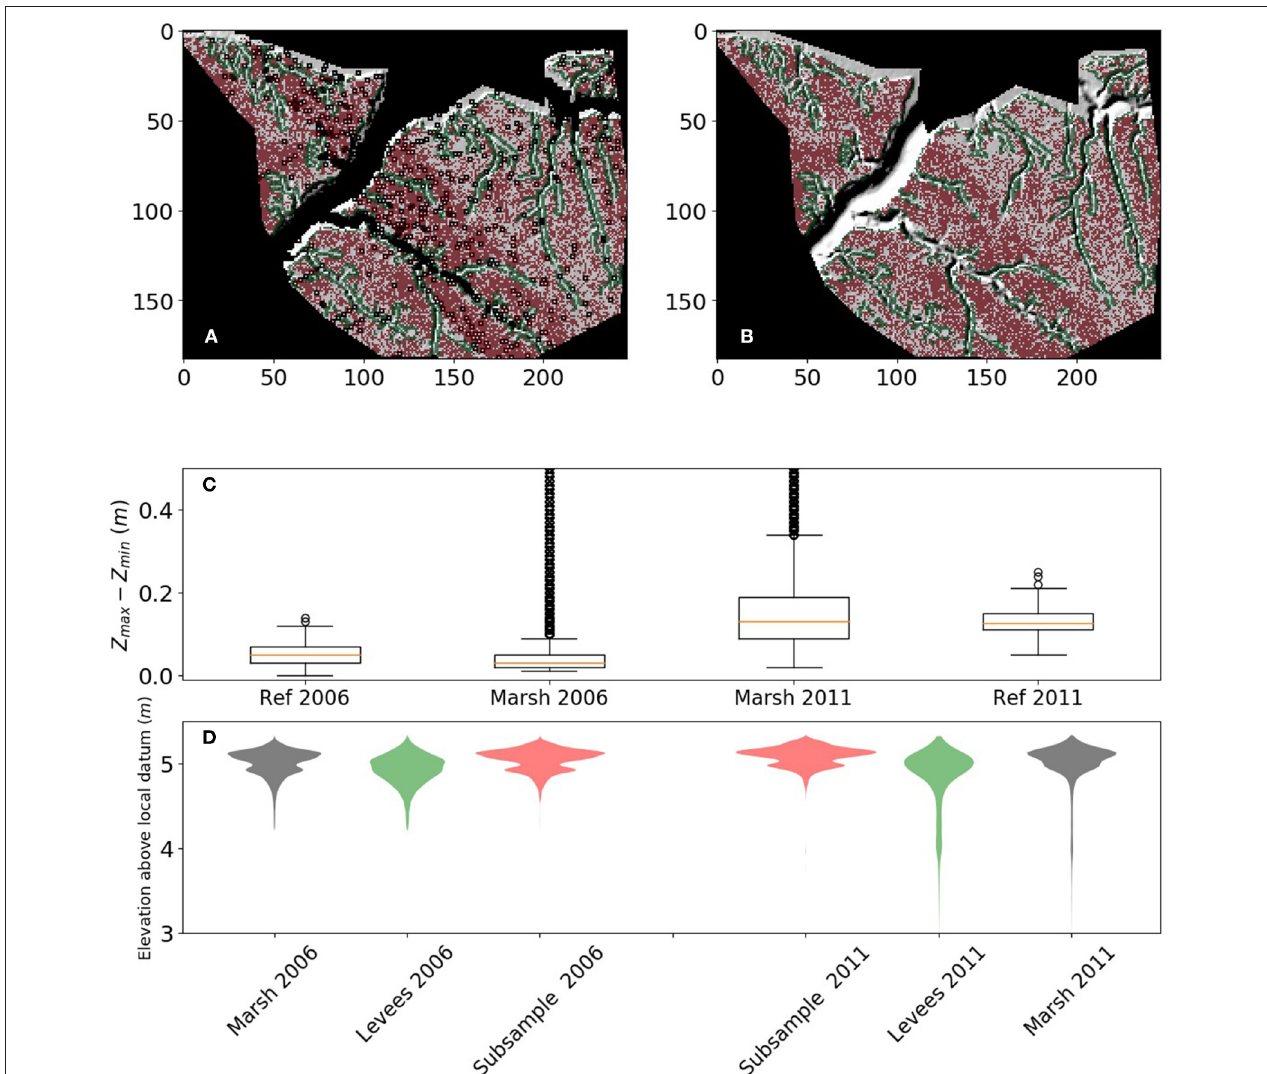
FIGURE 3 | Marsh platform subsampling results for the Mersey Estuary Marsh. (A,B) Show the marsh hillshade (respectively for S 1 and S 2) overlayed with subsampled pixels (red) and levee pixels (green). (C) Boxplot of differences Z max − Z min for the reference infrastructure and the marsh platform. (D) Probability distribution functions for the entire marsh platform (gray), levee pixels (green), and subsample pixels